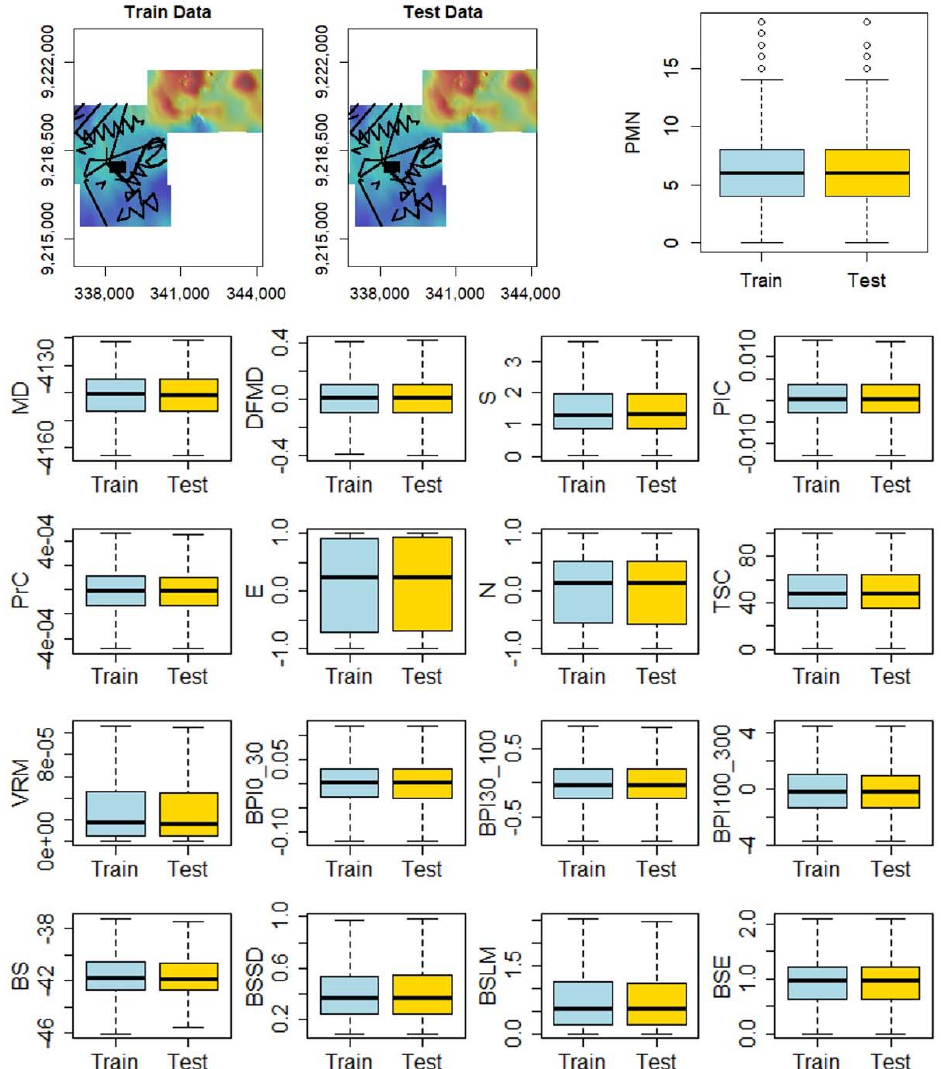
Figure A3. Top left: train and test dataset distribution have the same geographical coverage and distribution characteristics. The MBES derivative values were extracted at each photo location using the Extract Multi Values to Points tool (Spatial Analyst) in ArcMap 10.6.